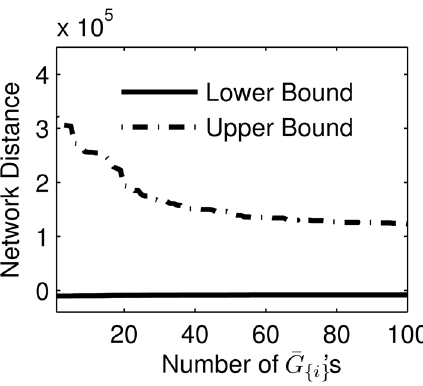
Figure 6. Ensemble inference and inferability of 5 , 000 random scale-free networks of order (a) n ~ 10 and (b) n ~ 100 genes. The mean network distances of the lower and upper bounds from G 6 0 are shown as a function of network size (i.e. number of edges). The error bars indicate the standard deviations.